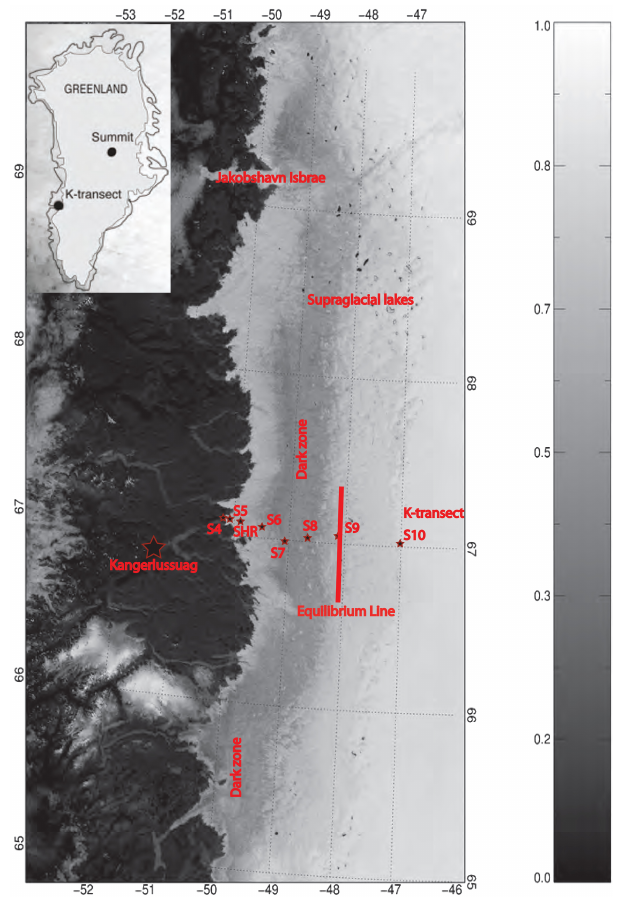
Figure 1. MODIS daily reflectance (band 620–670nm) indicated by the colour bar on the right-hand side from 21 August 2012, in- cluding the sites of the K-transect relative to the ice margin, the dark zone with lower surface albedo and supraglacial lakes. Flow direc- tion is from east to west. The region is characterized by a lack of lakes at the end of the summer season.